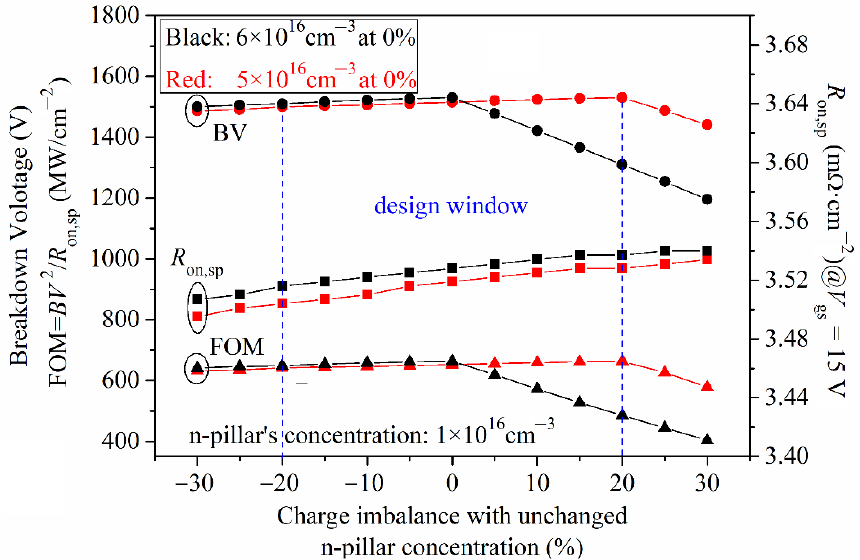
Figure 14. Relationship curves of BV, R on,sp and FOM versus charge imbalance for BSJ-UMOS.